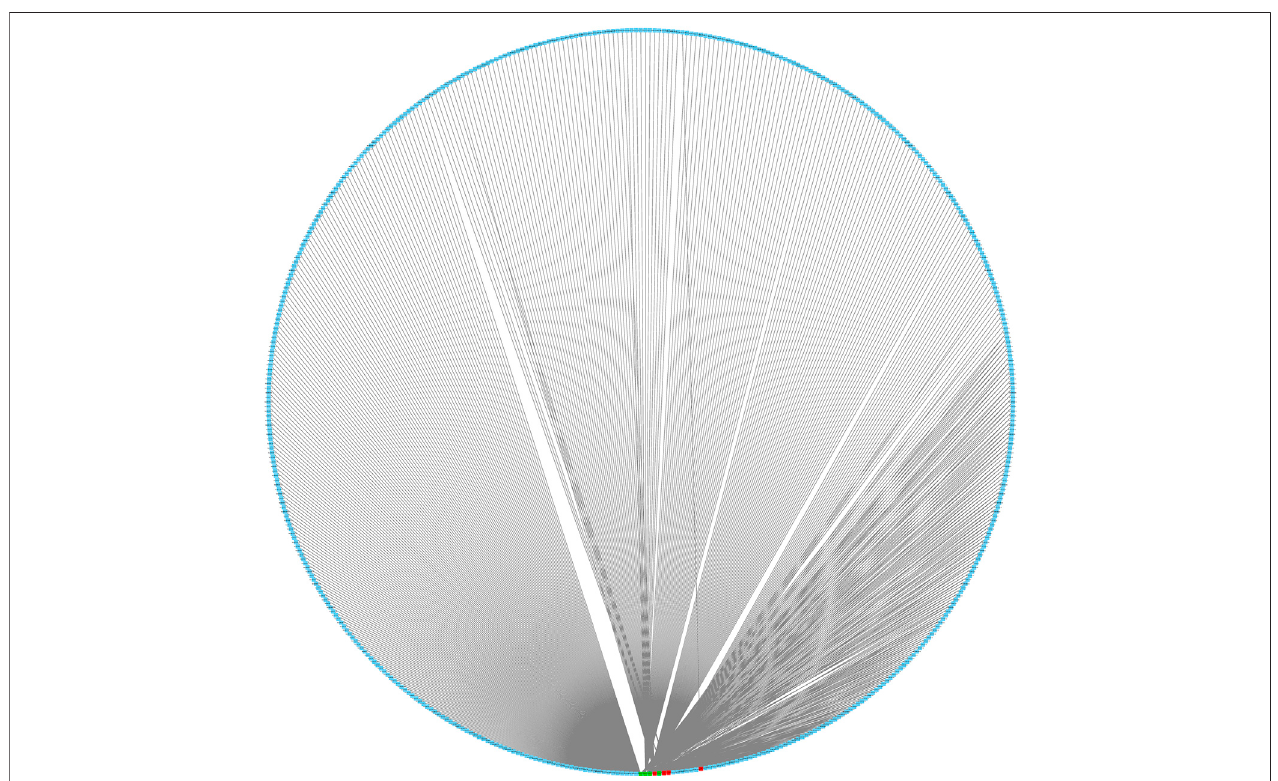
FIGURE 5 | Interaction network of eight mRNA and reverse-predict miRNA. Red cubes represented highly expressed mRNA, green cubes represent lowly expressed mRNA, and blue cubes represent miRNA.